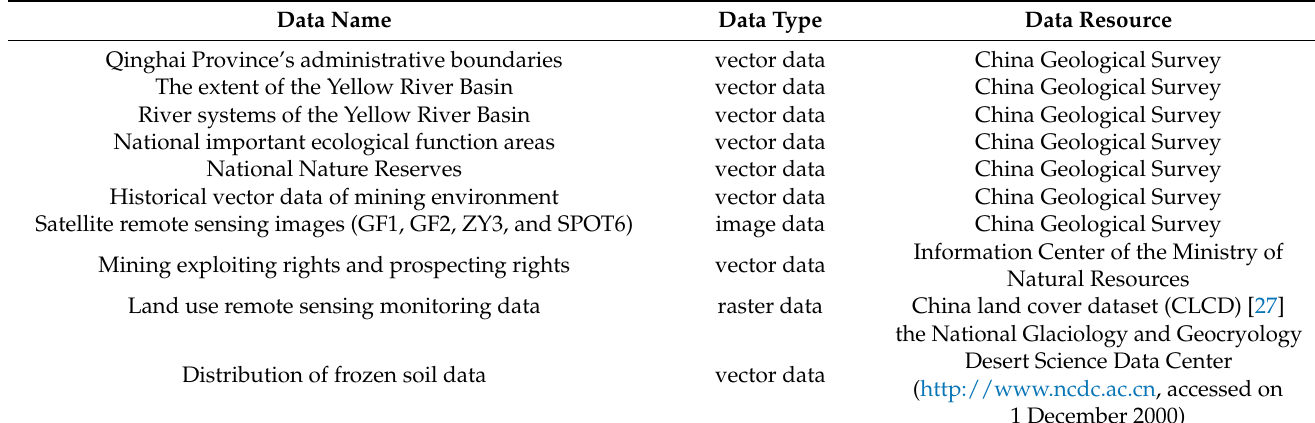
Table 1. Research data.